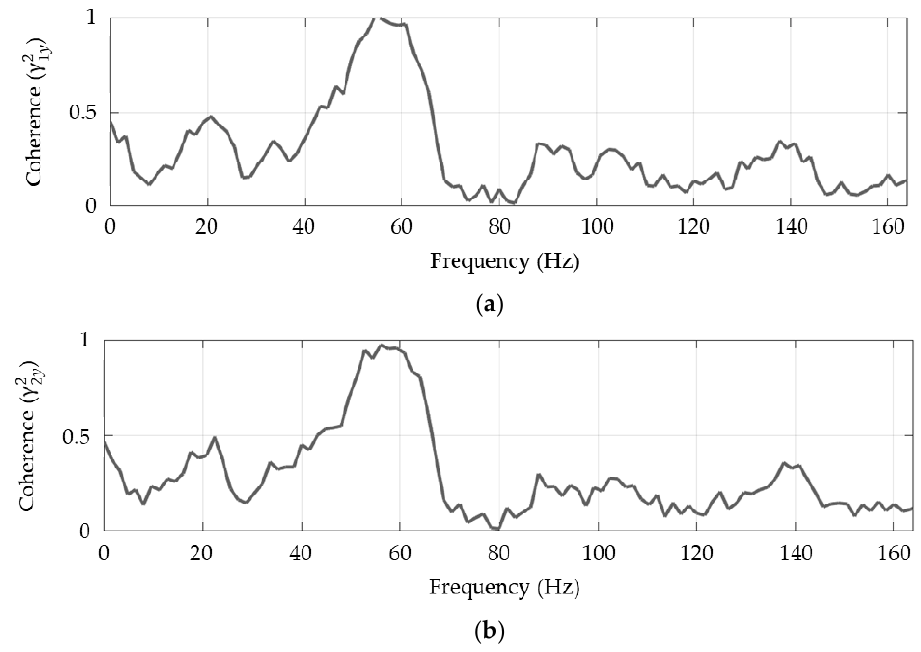
Figure 13. Ordinary coherence: ( a ) γ (cid:2869)(cid:3052)(cid:2870) , ( b ) γ (cid:2870)(cid:3052)(cid:2870) .